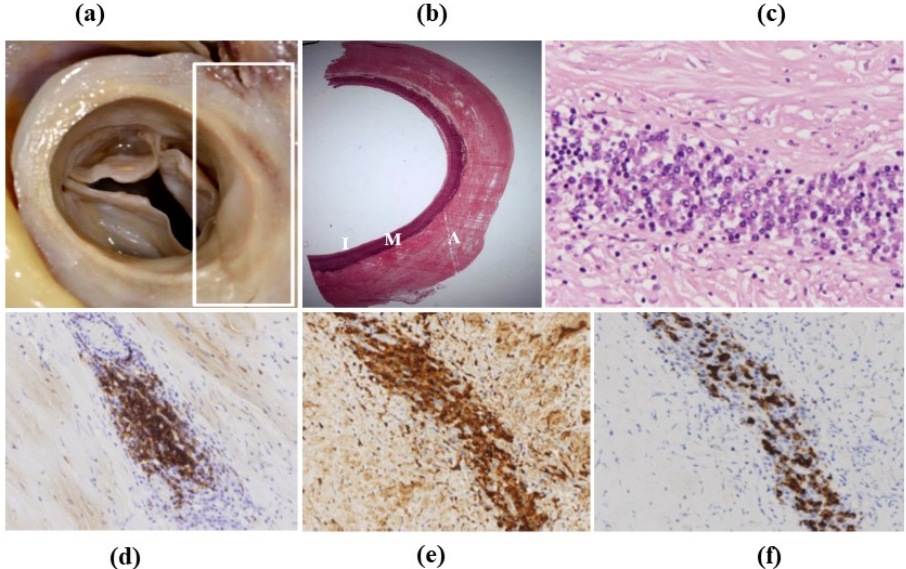
Figure 27. IgG4 aortitis. ( a ) Ascending aorta with increased thickness of the wall. ( b ) Histology: the